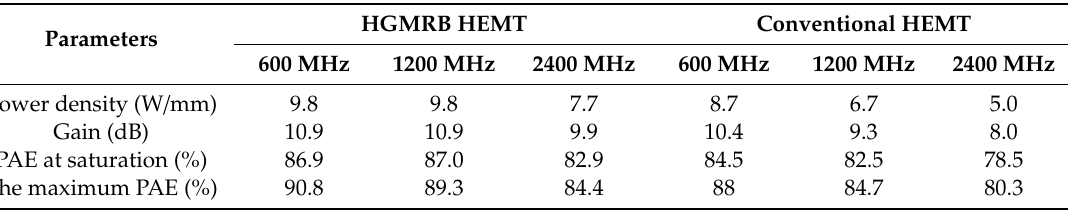
Figure 9. Large-signal performance of the two devices at di ff erent frequencies: ( a ) 600 MHz, ( b ) 1.2 GHz, and ( c ) 2.4 GHz. Table 3. Comparison of output characteristics between the two structures at di ff erent frequencies. PAE—power-added e ffi